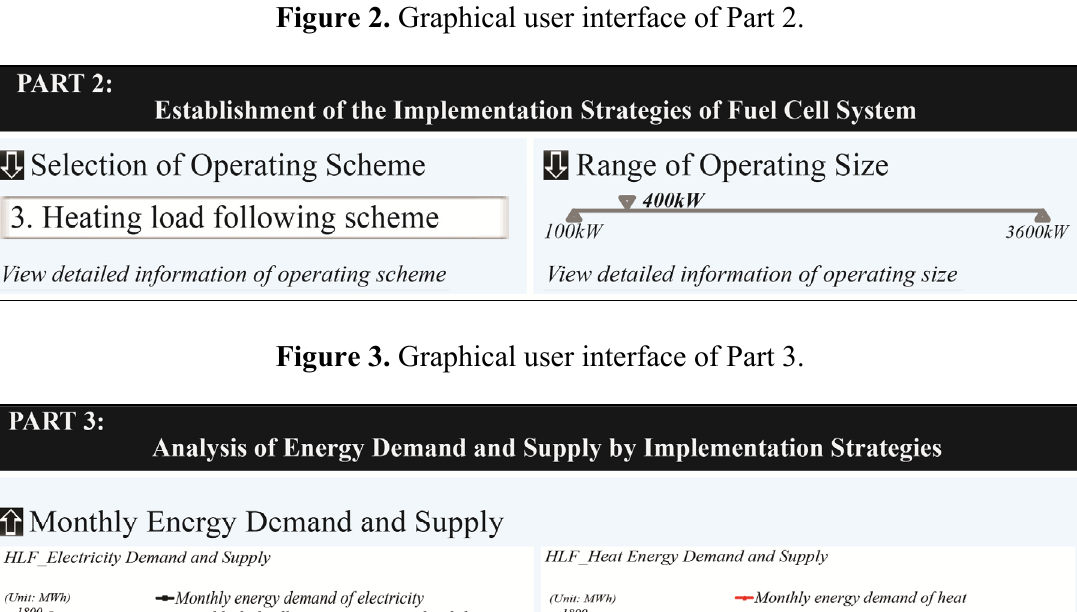
Figure 2. Graphical user interface of Part 2.